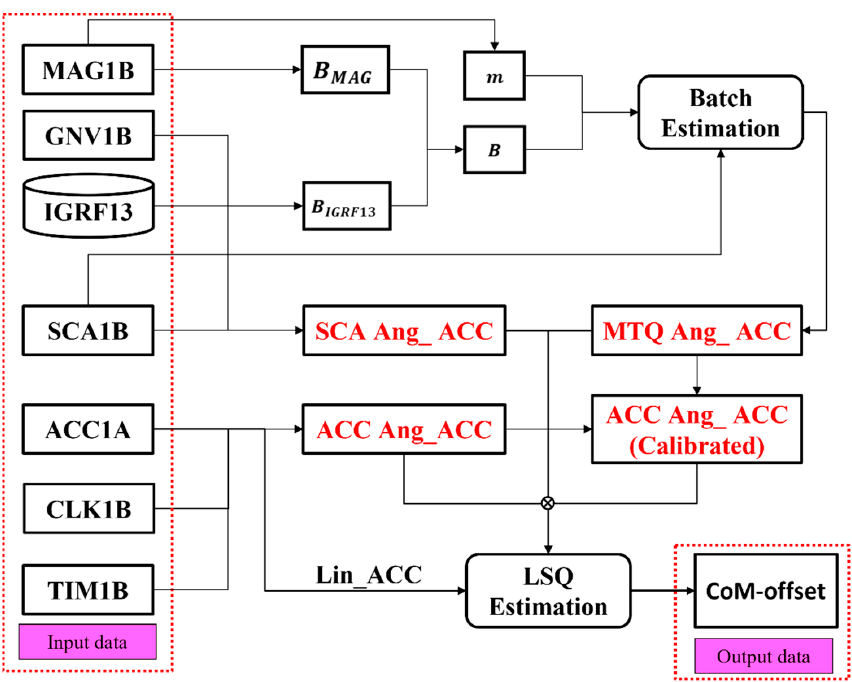
Figure 3. Flowchart of the CM-offset estimation based on four kinds of angular acceleration.